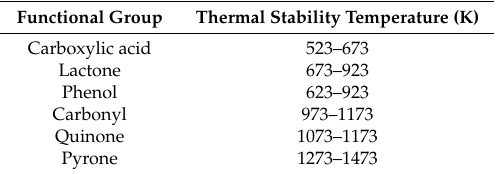
Table 1. Thermal stability temperature of functional groups on activated carbon.